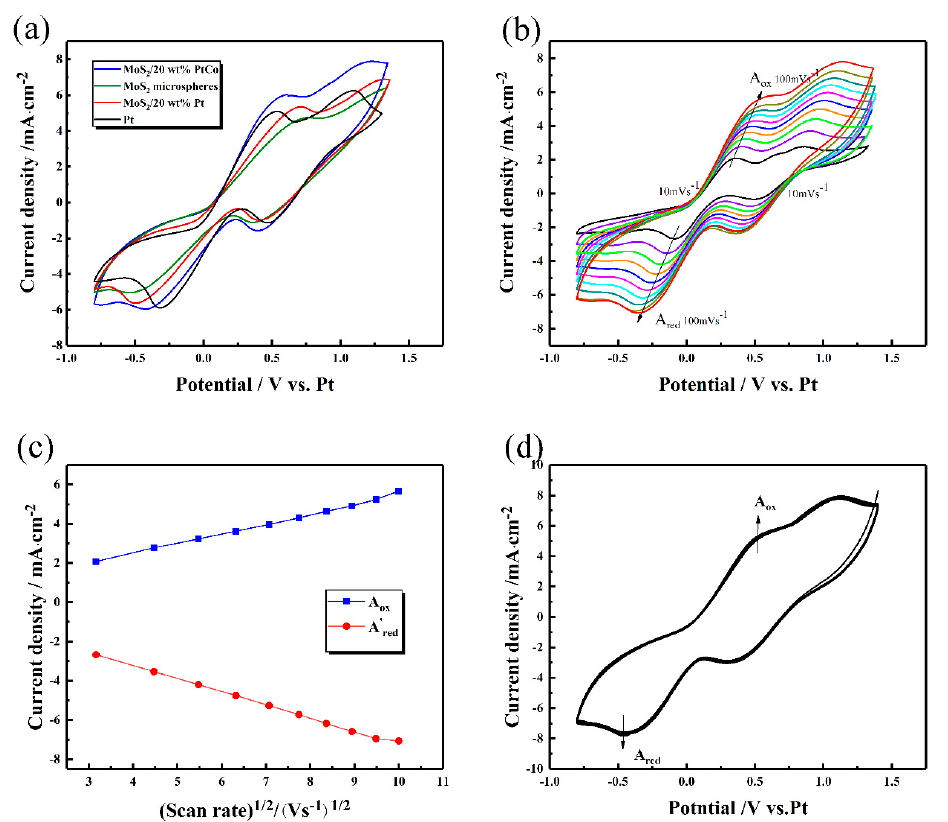
Figure 6. ( a ) Cyclic voltammetry (CV) for counter electrodes based on the di ff erent materials; ( b ) CVs for the MoS 2 / PtCo-alloy NP composites with di ff erent scan rates (from 10 mV s − 1 to 100 mV s − 1 , at the intervals of 10 mVs − 1 ); ( c ) relationship of redox peak current density and square root of scan rate; ( d ) 100-times continuous cycle scan CVs for the MoS 2 / PtCo-alloy NP composite CEs at a scan rate of 100 mV s − 1 .